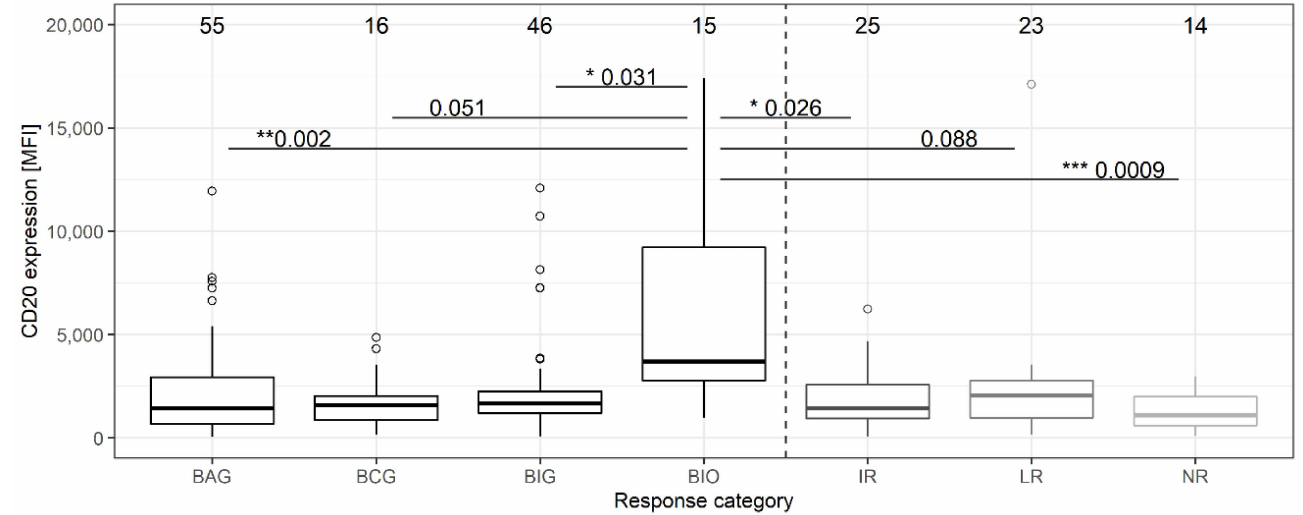
Figure 5. CD20 expression on CLL cells of patients in the MRD response groups prior to therapy start. Number of patients in each group is given above. Reported p -values for group differences were obtained from Dunn’s test. BCG, BAG, BIG, BIO: patients with deep (uMRD) MRD response under the respective trial schemes (B: Bendamustine; I: Ibrutinib; A: Venetoclax; C: Idelalisib; G: Obinutuzumab; O: Ofatumumab), IR: intermediate MRD response; LR: limited MRD response; NR: Non-Responders; IR/LR/NR include patients from the different trial schemes. * p ≤ 0.05; ** p ≤ 0.01; *** p ≤